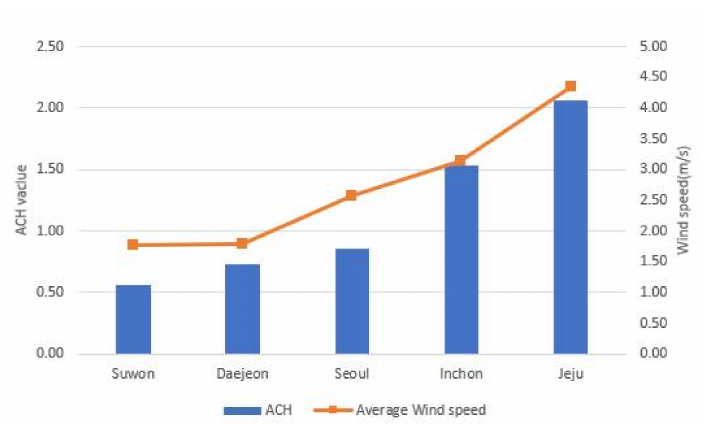
Figure 14. Annual average wind speed and infiltration rate calculated with the AFN method using weather data from several